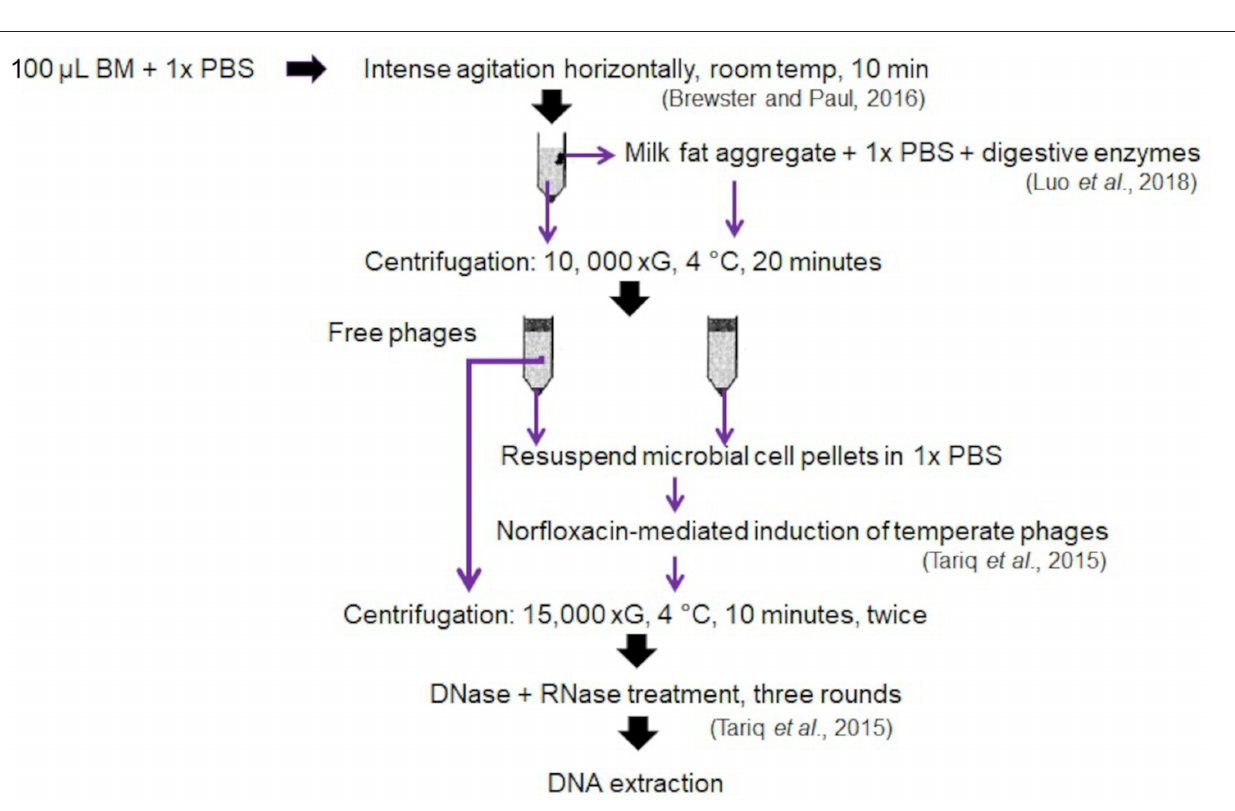
FIGURE 4 | Optimized phage isolation protocol generated from the validation of different tested